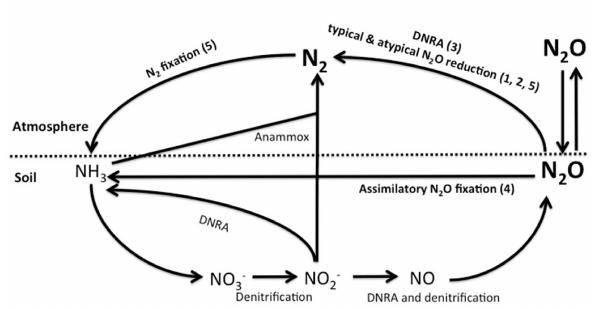
Figure 3. The N 2 O production and consumption network show- ing five pathways for N 2 O consumption. Dissimilatory N 2 O reduc- tion to N 2 via typical, denitrifier nosZ I (1); atypical, non-denitrifier nosZ II (2); dissimilatory NO − reduction to NH 3 (DNRA) (3); di- 3 rect assimilatory N 2 O fixation via nitrogenase to NH 3 (4); and in- direct assimilatory N 2 O fixation (N 2 O reduction to N 2 followed by N 2 fixation) (5). Abiotic pathways that produce gaseous N (Feam- mox and chemo-denitrification) are not